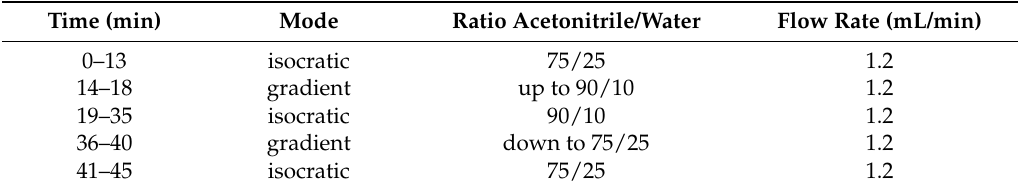
Table 2. Time program for High Performance Liquid Chromatography (HPLC) analysis of triterpenoids contained in birch